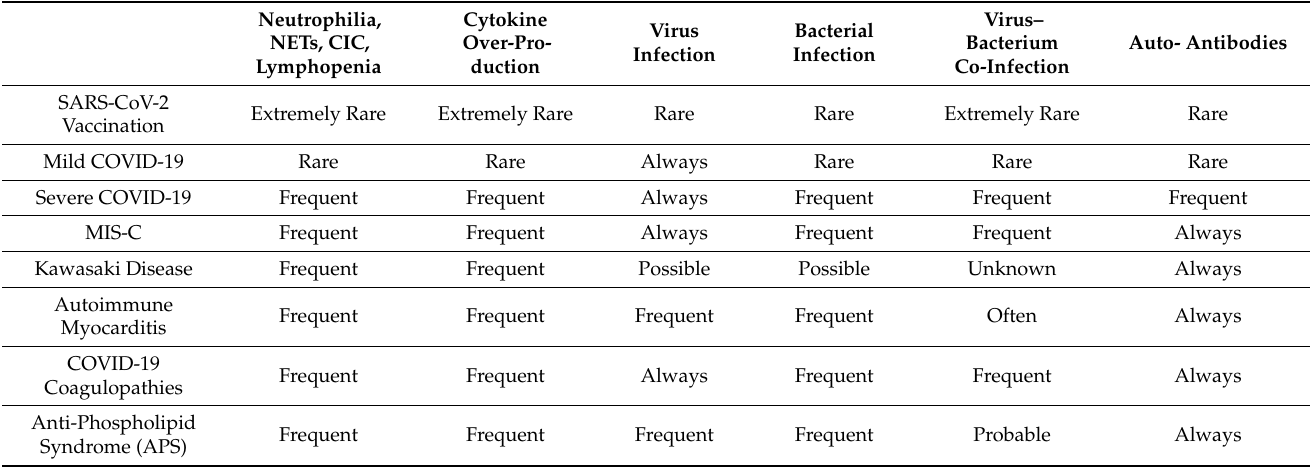
Table 2. General overview based on sources in Introduction relating measures of innate immune system activation, possibility of co-infections with viruses and bacteria and presence of autoanti- bodies in various SARS-CoV-2-associated syndromes: NETs = neutrophil extracellular traps; MIS-C (PIMS) = Multisystem Inflammatory Syndrome in Children, sometimes called Pediatric Inflammatory Multisystem Syndrome Temporally Associated with SARS-CoV-2. Virus infection = SARS-CoV-2 in the COVID-19 cases or in vaccination, mild or severe COVID-19, MIS-C and COVID-19 coagu- lopathies, but refers to other viruses (see text) in the cases of autoimmune myocarditis and APS. Bacterial Infection = any bacterial infection epidemiologically associated with the disease listed in the left-most column. Information on autoimmune myocarditis from